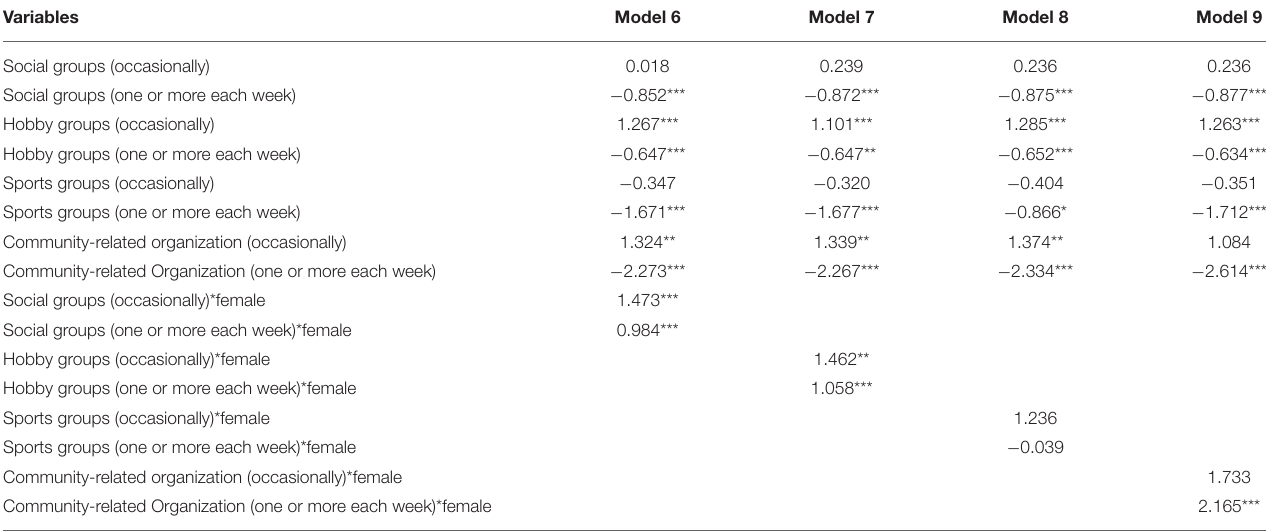
TABLE 3 | The interaction effect between gender and social participation on CESD-10 scores in older people ( n = 6,287).